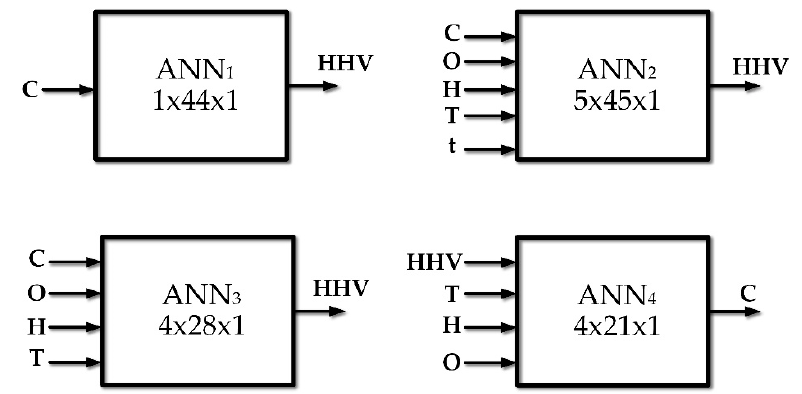
Figure 3. ANN models for hydrothermal carbonization. Each ANN box has the input hydrochar parameter(s) on the left, the output parameter on the right, and the number of neurons of the input, the hidden and the output layers inside.